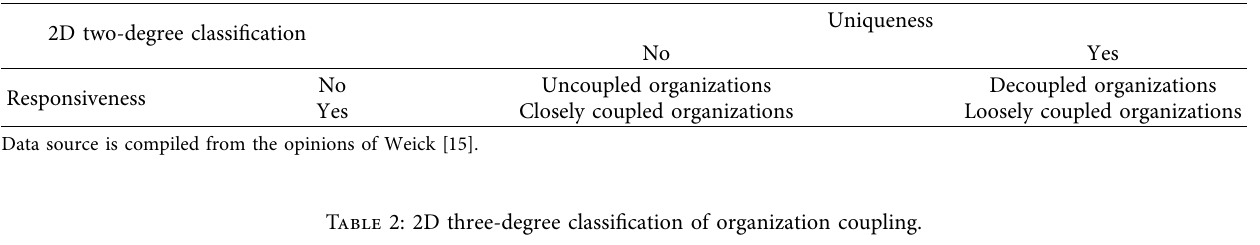
Table 1: 2D three-degree classification of organization coupling.